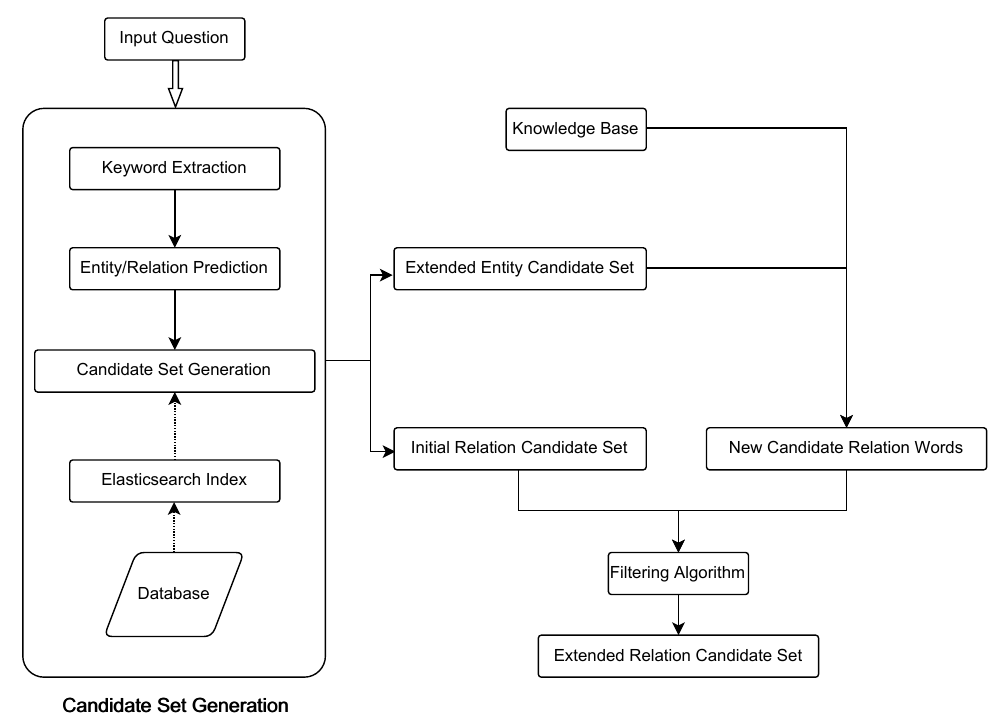
Figure 7. Framework diagram of the relation candidate set expansion